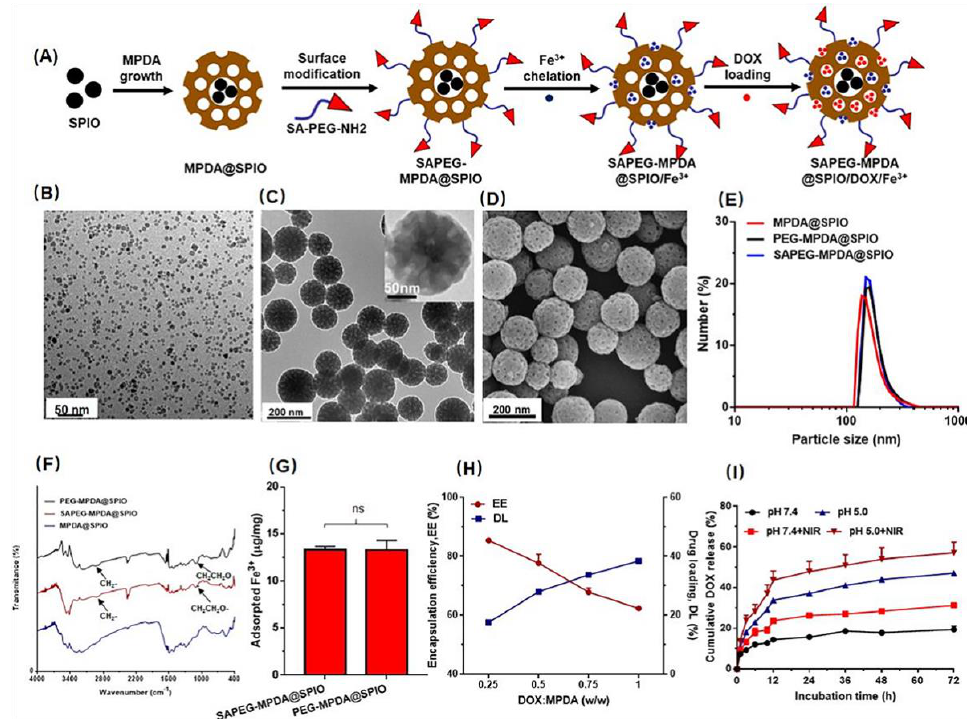
Figure 5. ( A ) Schematic illustration of the preparation of SAPEG-MPDA@SPIO/DOX/Fe 3+ NPs. ( B ) TEM images of SPIO NPs. ( C ) TEM images of SAPEG-MPDA@SPIO NPs. ( D ) SEM images of SAPEG-MPDA@SPIO NPs. Particle size distribution ( E ) and FTIR spectra ( F ) of MPDA@SPIO, PEG-MPDA@SPIO and SAPEG-MPDA@SPIO NPs. ( G ) The amount of Fe 3+ chelated by PEG-MPDA@SPIO NPs and SAPEG-MPDA@SPIO NPs (ns is non-significant, n = 3). ( H ) The DOX encapsulation efficiency (EE) and drug loading capability (DL) of SAPEG-MPDA@SPIO/Fe 3+ NPs. ( I ) The DOX release profiles of SAPEG. MPDA@SPIO/DOX/Fe 3+ NPs. Reproduced with permission from ref. [47]. Copyright © 2022, KeAi.